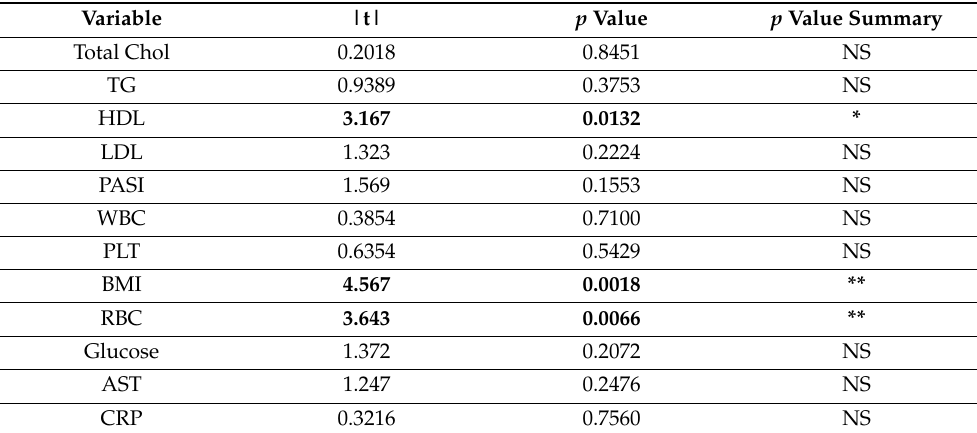
Table 4. Multiple linear regression independent association between ITGB7 levels and included variables in patients with lichen